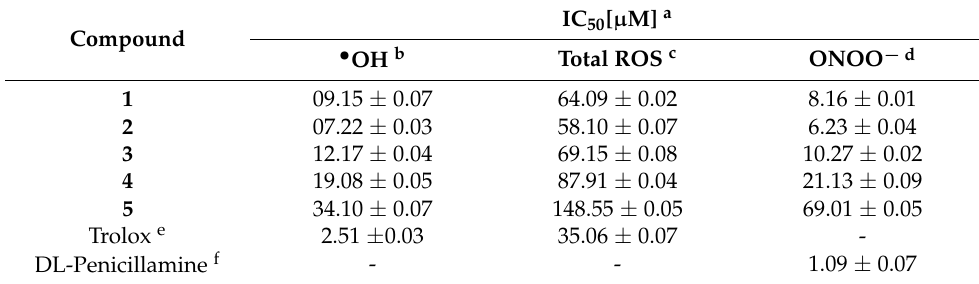
Table 3. Antioxidative activity of Compounds